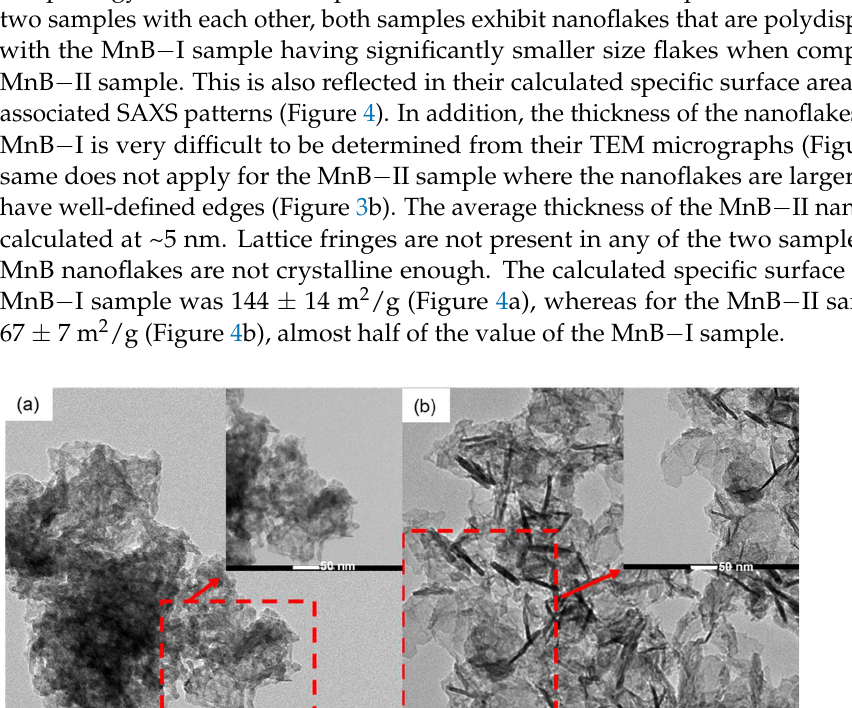
Figure 2. XRD patterns of ( a ) MnB−I and ( b ) MnB−II.